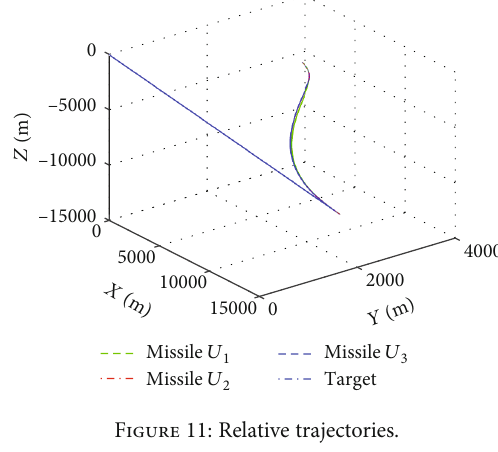
Figure 11: Relative trajectories.